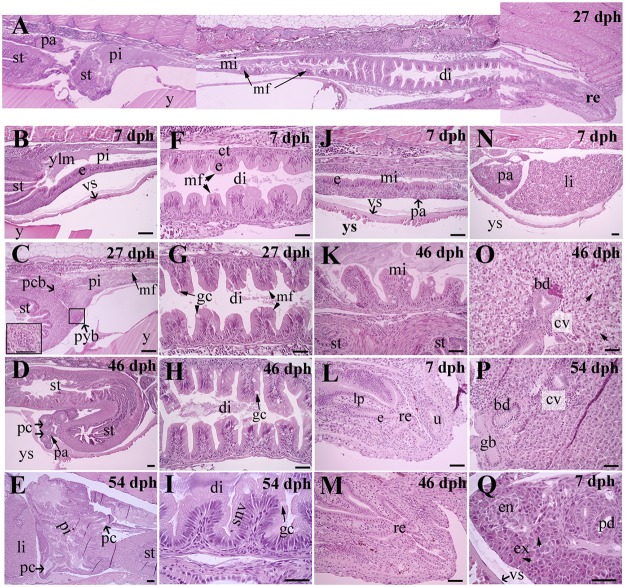
Representative sagittal sections of intestine, liver and pancreas of Atlantic salmon juveniles at various time points (days post hatch [dph]).
(A) General overview of the intestine at 27 dph; (B-E) Development of the proximal intestine; absence of pyloric caeca at 7 dph (B), appearance of pyloric caeca buds at 27 dph (C), and more developed pyloric caeca at 46 and 54 dph (D and E); (F-I) Development of the distal intestine; presence of incipient mucosal folds without goblet cells at 7 dph (F), appearance of mucosal folds scattered with goblet cells (arrows) within epithelium at 27, 46 and 54 dph (G-I), and presence of low level of supranuclear vacuoles at 54 dph (I); (J-K) Development of the mid intestine; simple epithelium without goblet cells at 7 dph (J), and following appearance of mucosal folds scattered with goblet cells at 46 dph (K); (L-M) Development of the rectum (re); epithelium consisting of cuboidal cells devoid of mucus cells at 7 (L) and 46 (M) dph; (N-P) Development of the liver (li) consisting of polygonal hepatocytes with a prominent basophilic nucleus and eosinophilic cytoplasm irregularly arranged along the sinusoids around a central vein; increasing accumulation of glycogen-containing vacuoles (arrows) in hepatocytes from 7 (N) to 46 (O) dph; low level of glycogen deposit in liver following start-feeding at 54 dph (P); (Q) Fully differentiated pancreatic tissue composed of exocrine cells with zymogen granules (arrows), endocrine cells grouped in Langerhans islets, and pancreatic ducts at 7 dph. Abbreviations: bd, bile duct; ct, connective tissue; cv, central vein; di, distal intestine; e, epithelium; en, endocrine pancreas (Langerhans islet); ex, exocrine pancreas; gb, gallbladder; gc, goblet cell; li, liver; lp, lamina propria containing connective tissue; mf, mucosal folds; mi, mid intestine; pa, pancreas; pc, pyloric caeca with simple, columnar epithelium and goblet cells; pd, pancreatic duct; pi, proximal intestine; pyb, pyloric caeca bud; re, rectum; snv, supranuclear vacuoles; st, stomach; u, urinary opening; vs, vitelline syncytium; y, yolk; ylm, yolk-like material; ys, yolk sac. Scale bar: (B-E) = 100 μm or (C, insert) = 50 μm; (F-Q) = 50 μm.